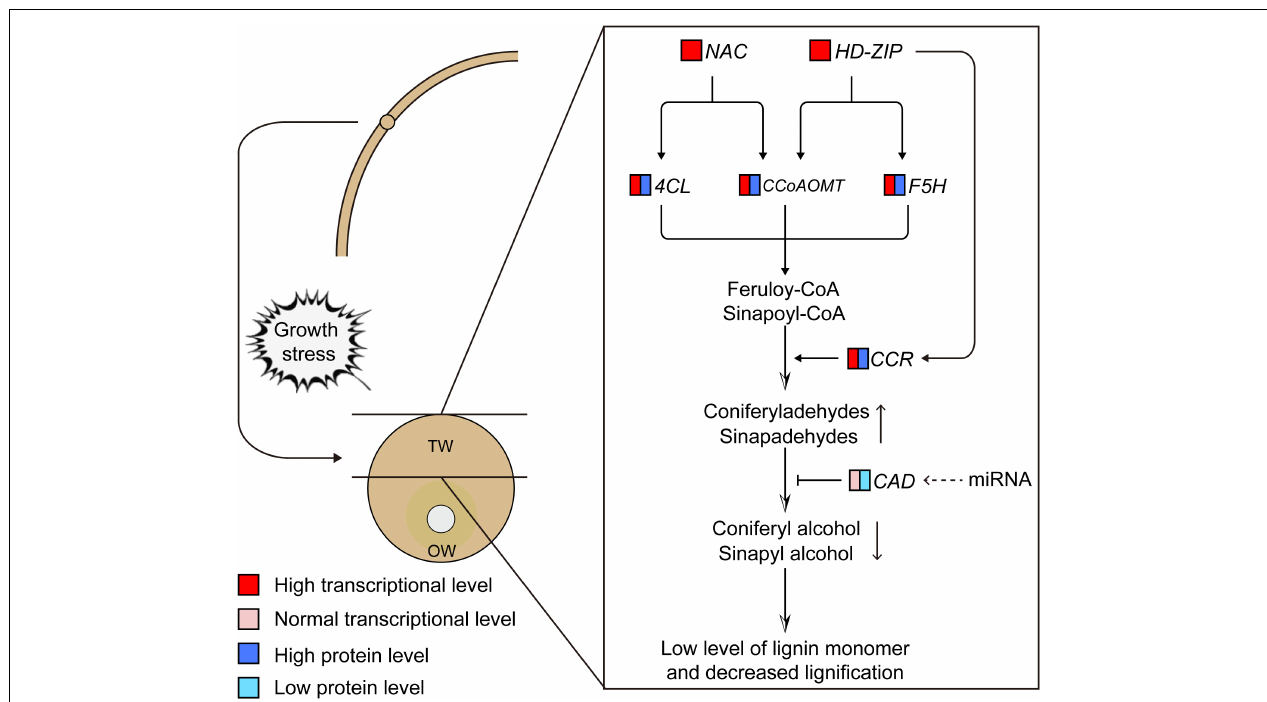
FIGURE 10 | Transcriptional regulation model of lignin monomer biosynthesis during tension wood (TW) formation in C. bungei . The dotted line represents the